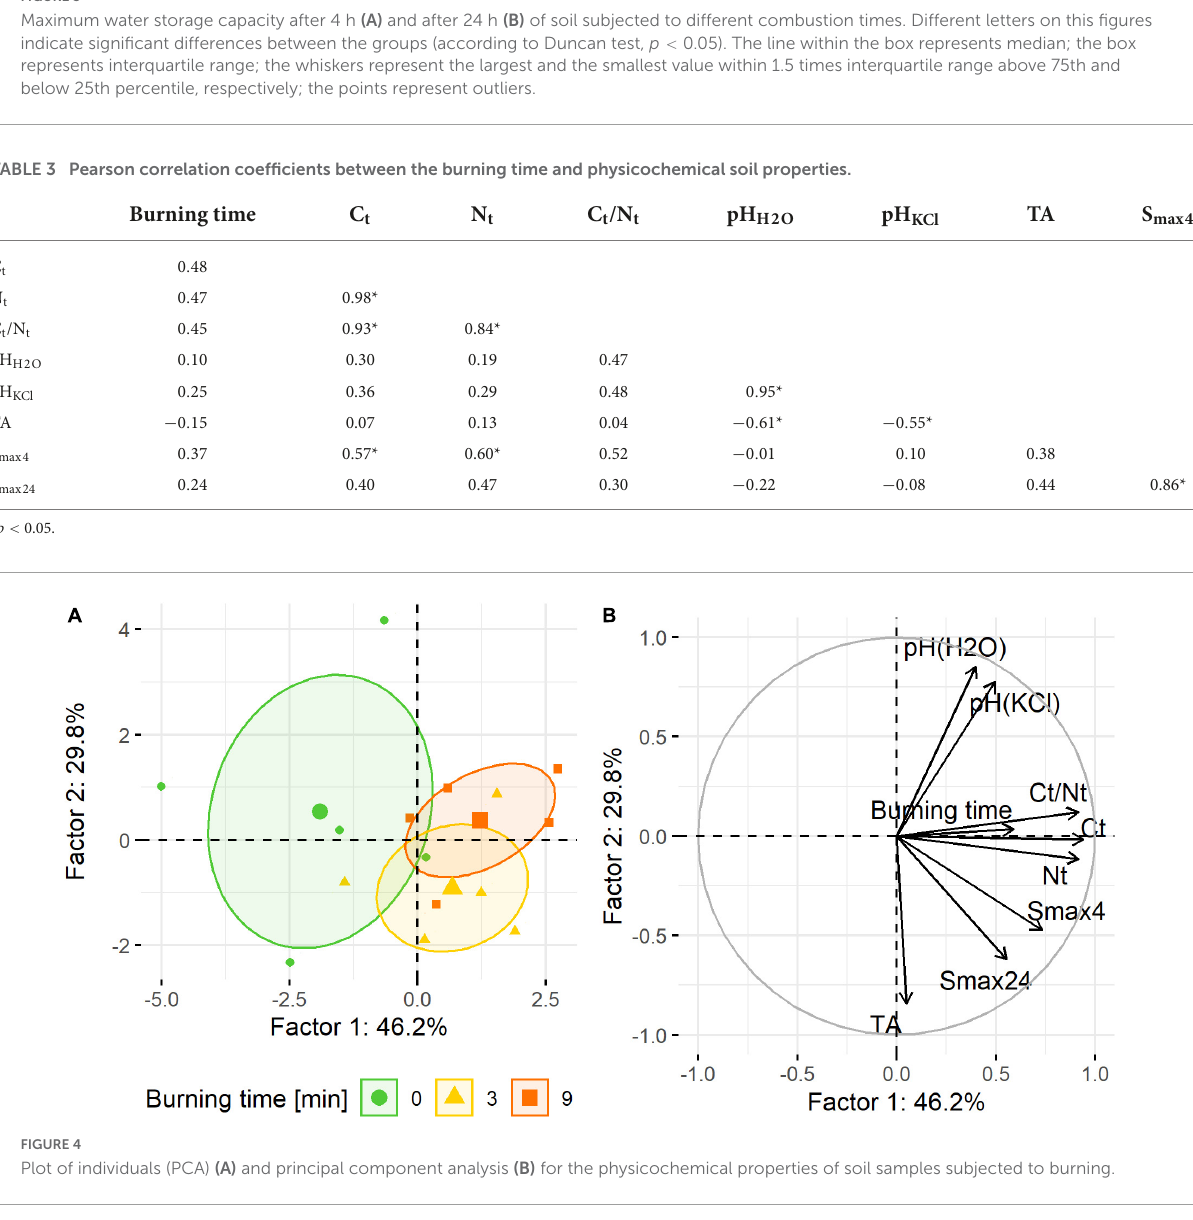
Frontiers in Forests and Global Change